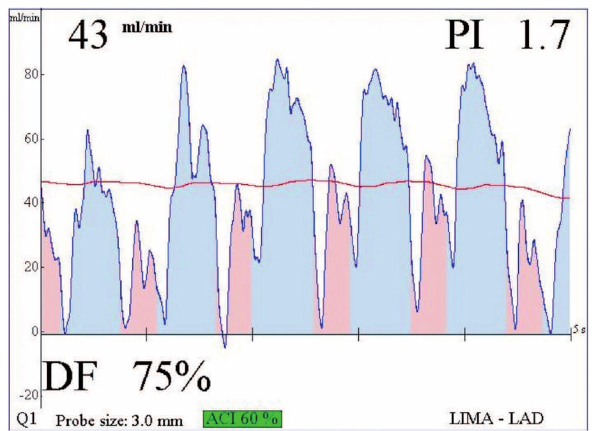
Fig. 1. Análise fluxométrica da DA. A linha em vermelho corresponde ao fluxo médio do enxerto, expresso em mL/min,